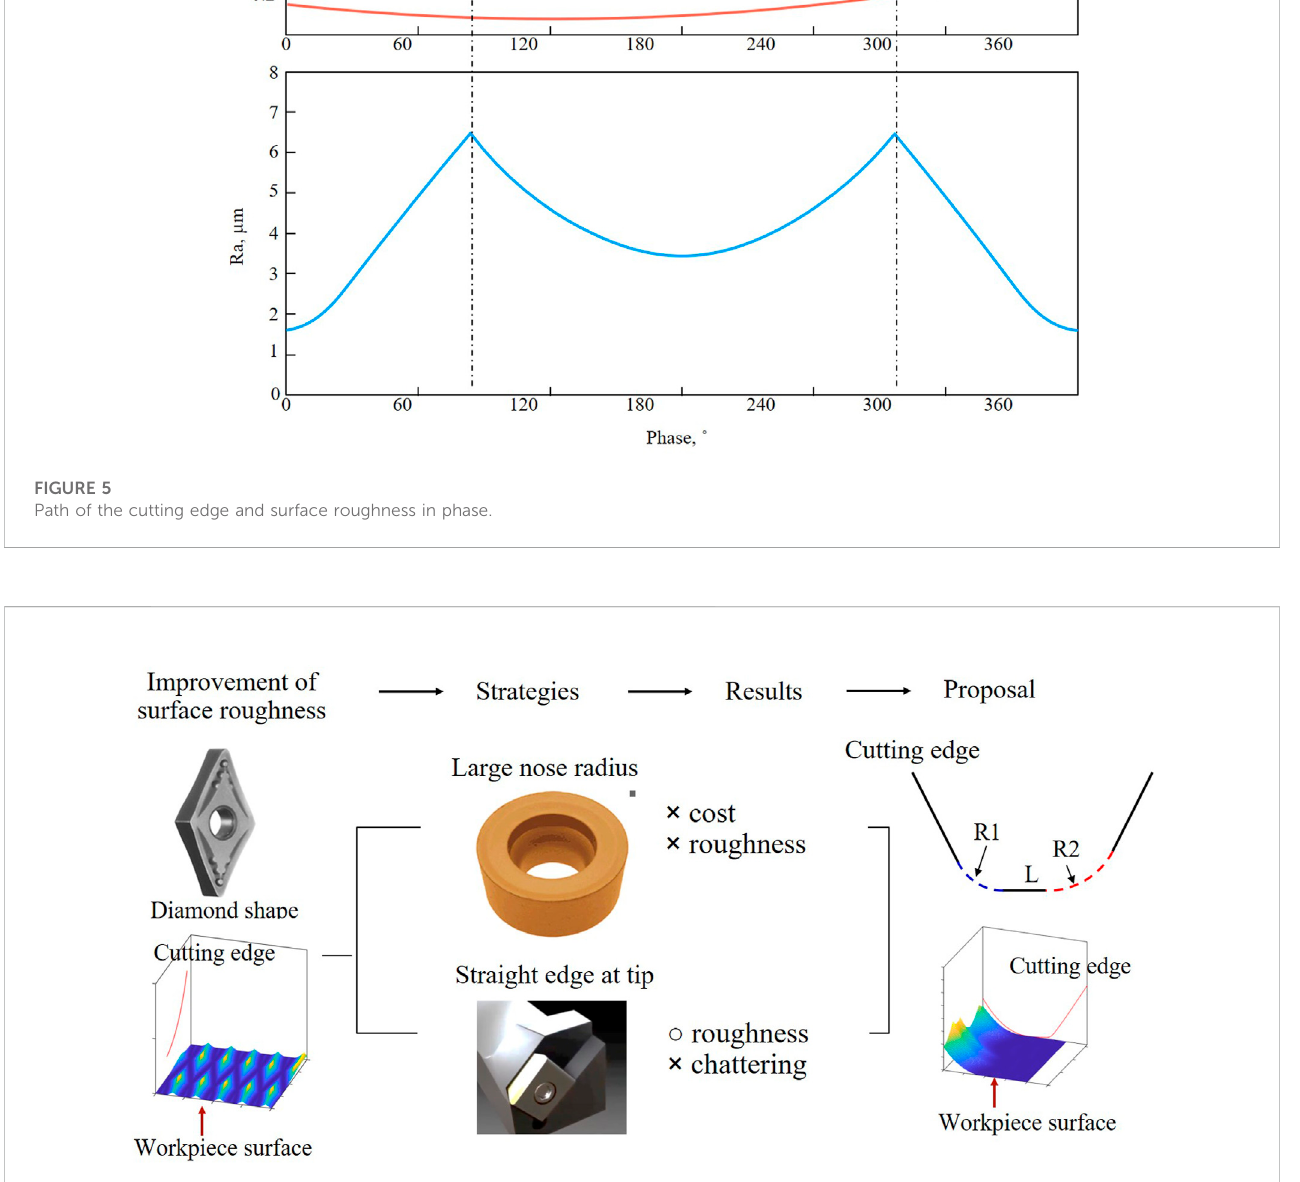
FIGURE 6 Design strategy of cutting tool for low-frequency vibration.